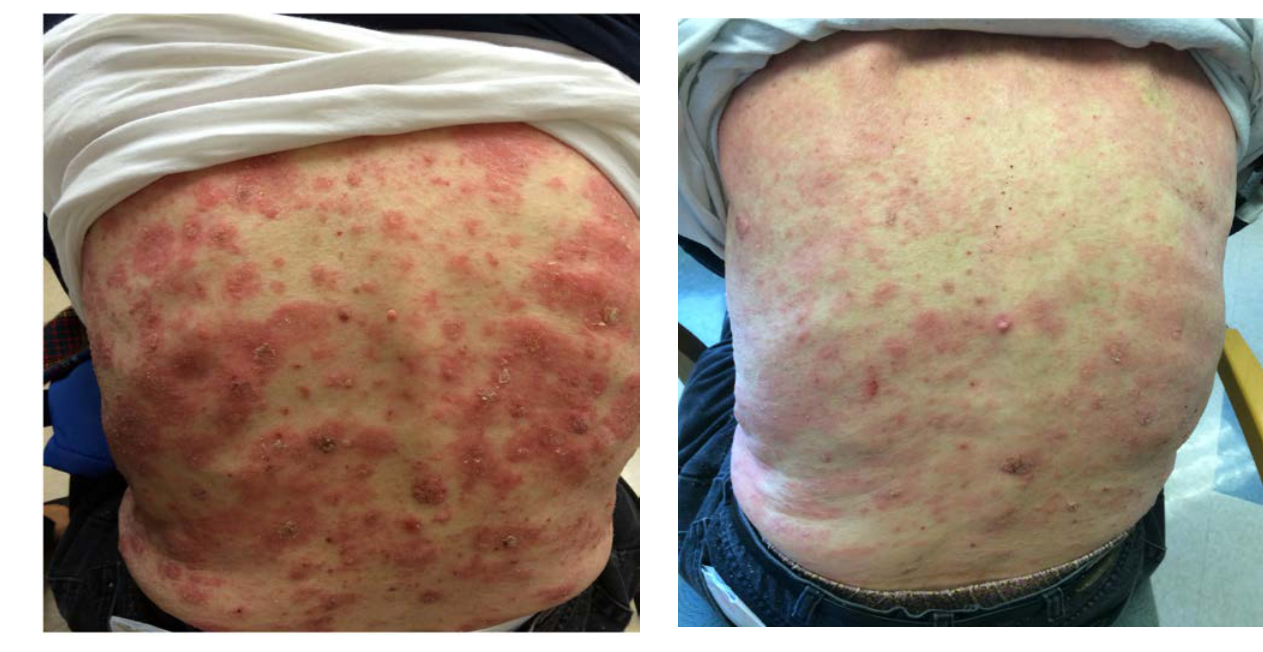
Figure 1. Pre brentuximab vedotin treatment, December 2015. Figure 2. Post brentuximab vedotin treatment, February